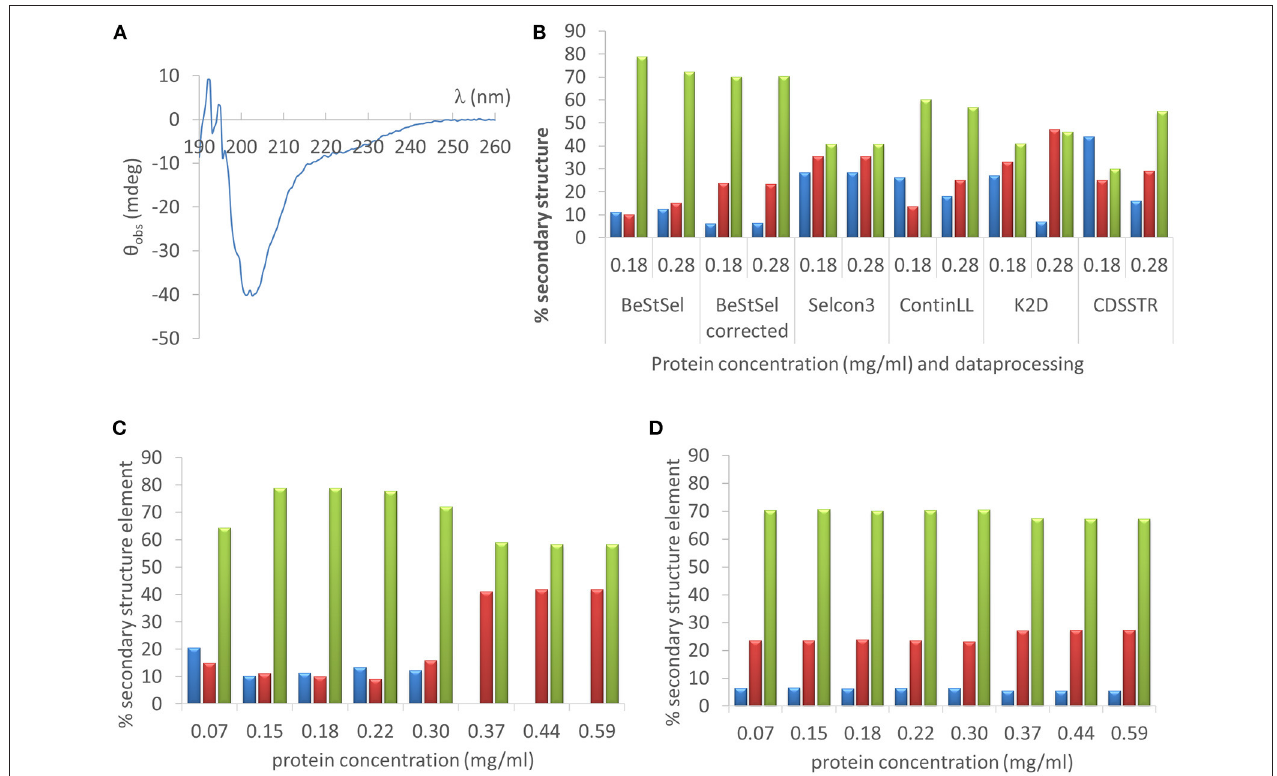
FIGURE 5 | Far UV CD analysis of hCSD1 (A) The far UV CD spectrum of hCSD1 corresponds to a prototypical spectrum of a random coil. (B) Deconvolution of the CD spectrum of hCSD1 by DichroWeb and BeStSel. The CD spectrum was deconvoluted by assuming two different hCSD1 concentrations (0.18 and 0.28 mg/ml) by either BestSel or through the DichroWeb server. BeStSel was run by two different options (without and with concentration correction), whereas on DichroWeb four different algorithms were used (Selcon3, ContinLL, K2D and CDSSTR). (C,D) Deconvolution of the CD spectrum of hCSD1 with BeStSel. The CD spectrum was deconvoluted to yield the % secondary structure composition ( α -helix, β -strand and coil) of hCSD1 by BeStSel. The program was run both without (C) and with (D) the application of “Best” factor correction at a broad, but not unrealistic, range of measured concentrations.